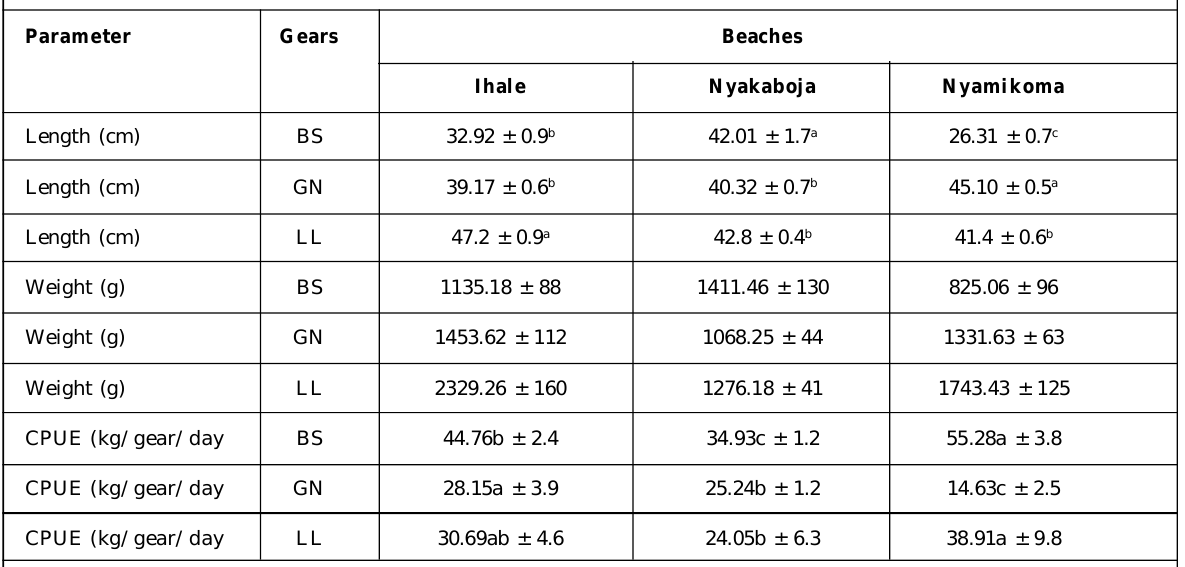
Table 1: Mean length, weight, condition factor and CPUE of Nile perch for each fishing gear at Ihale, Nyakaboja and Nyamikoma landing sites at Magu